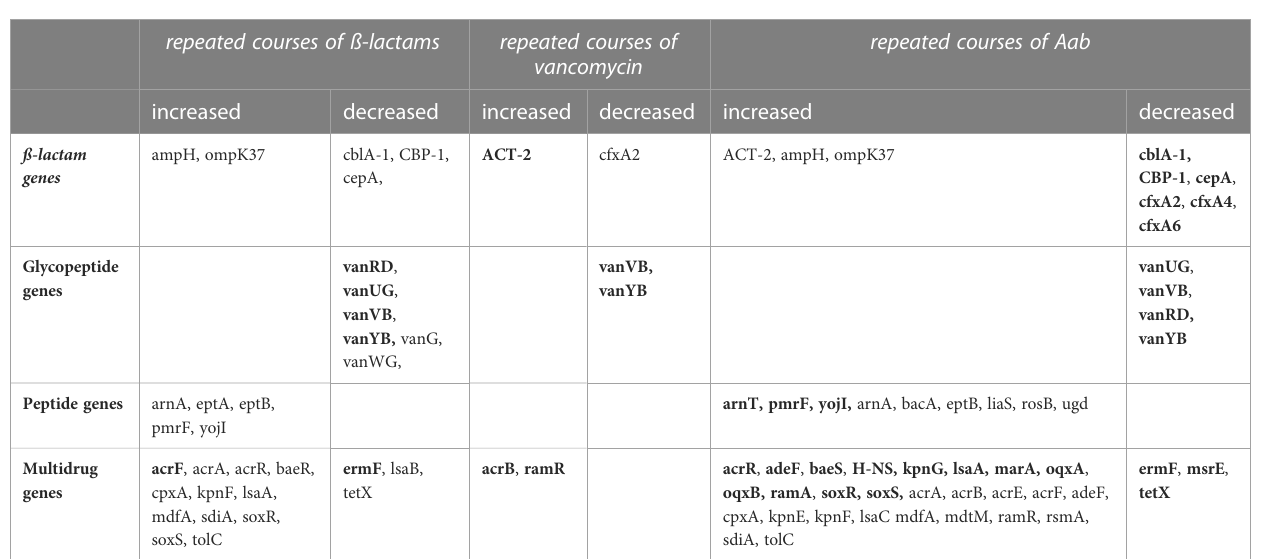
TABLE 4 Combined list of signi fi cant and candidate (correcting for confounders; p BH <0.1; p BH <0.05 in bold) ARGs from the ß-lactam, glycopeptide, peptide and multidrug antibiotic classes for different mean abundances with repeated courses (no use, 1-2 courses, 3+ courses), and/or counts of courses of ß-lactam, vancomycin or